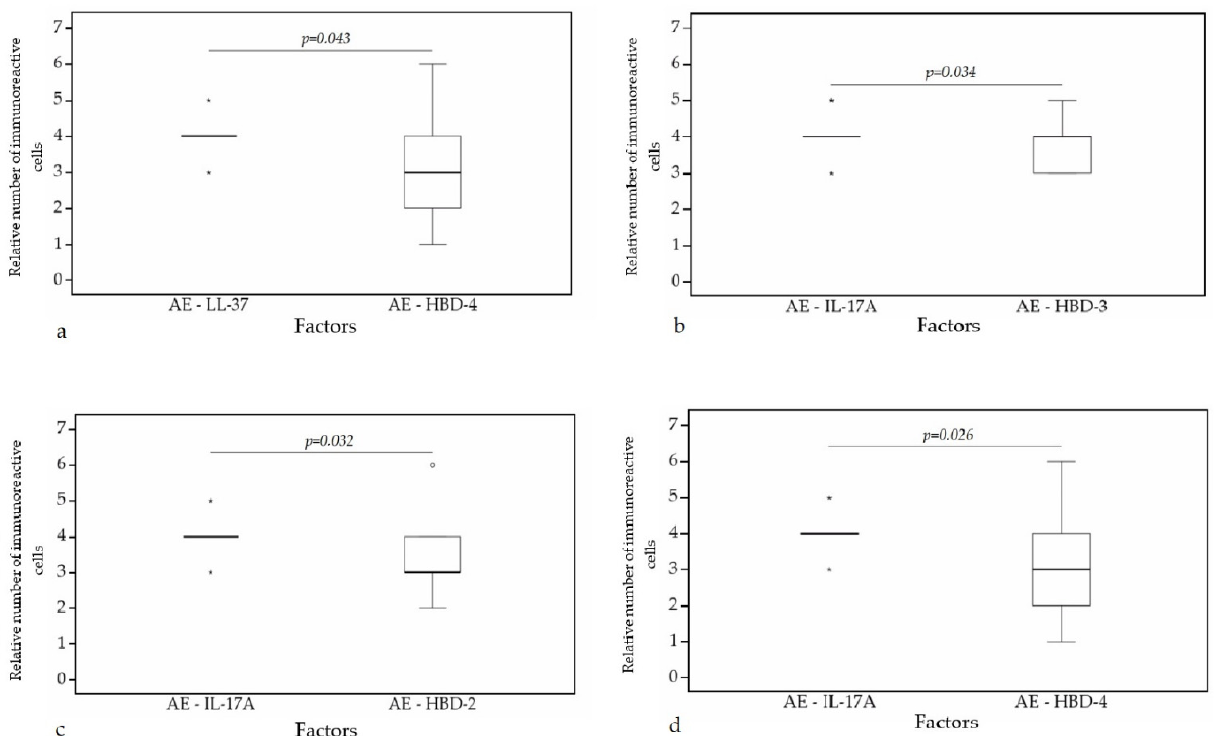
Figure 13. Wilcoxon test revealing statistically significant difference between the relative numbers of different factors in alve- olar epithelium. ( a ) A statistically significant difference between LL-37 and HBD-4 in alveolar epithelium. ( b ) A statistically significant difference between IL-17A and HBD-3 in alveolar epithelium. ( c ) A statistically significant difference between IL-17A and HBD-2 in alveolar epithelium. ( d ) A statistically significant difference between IL-17A and HBD-4 in alveolar epithelium. AE, alveolar epithelium; HBD-2, human β defensin 2; HBD-3, human β defensin 3; HBD-4, human β defensin 4; LL-37, cathelicidine; IL-17A, interleukin 17A; o—outlier data—indicates a higher or lower number of relative positive cells which lie more than 1.5 but less than 3.0 times the interquartile range below the first quartile or above the third quartile; *—extreme outlier data—indicates a higher or lower number of relative positive cells which lie more than 3.0 times the interquartile range below the first quartile or above the third